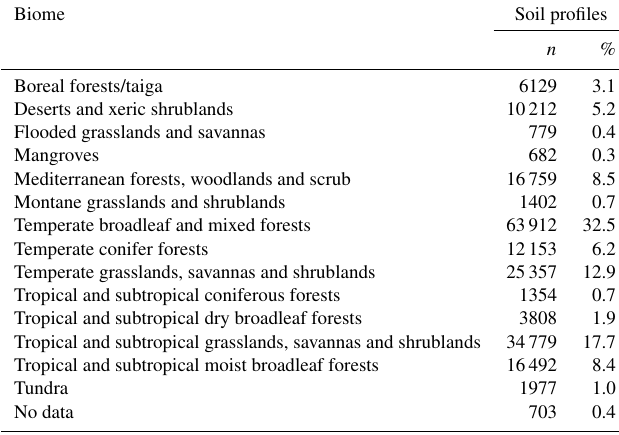
Table D2. Number of soil profiles by biome ∗ .